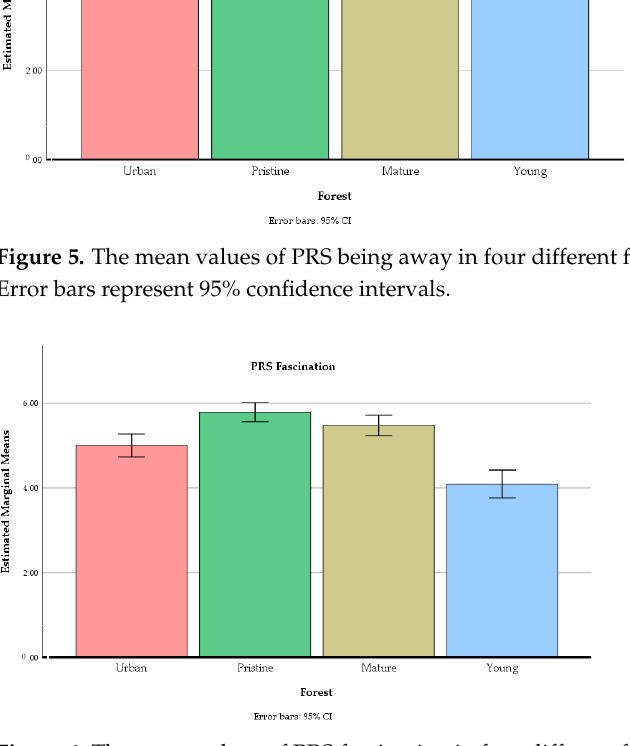
Figure 7. The mean values of PRS compatibility in four different forests at the end of the experi- ment. Error bars represent 95% confidence intervals. 0